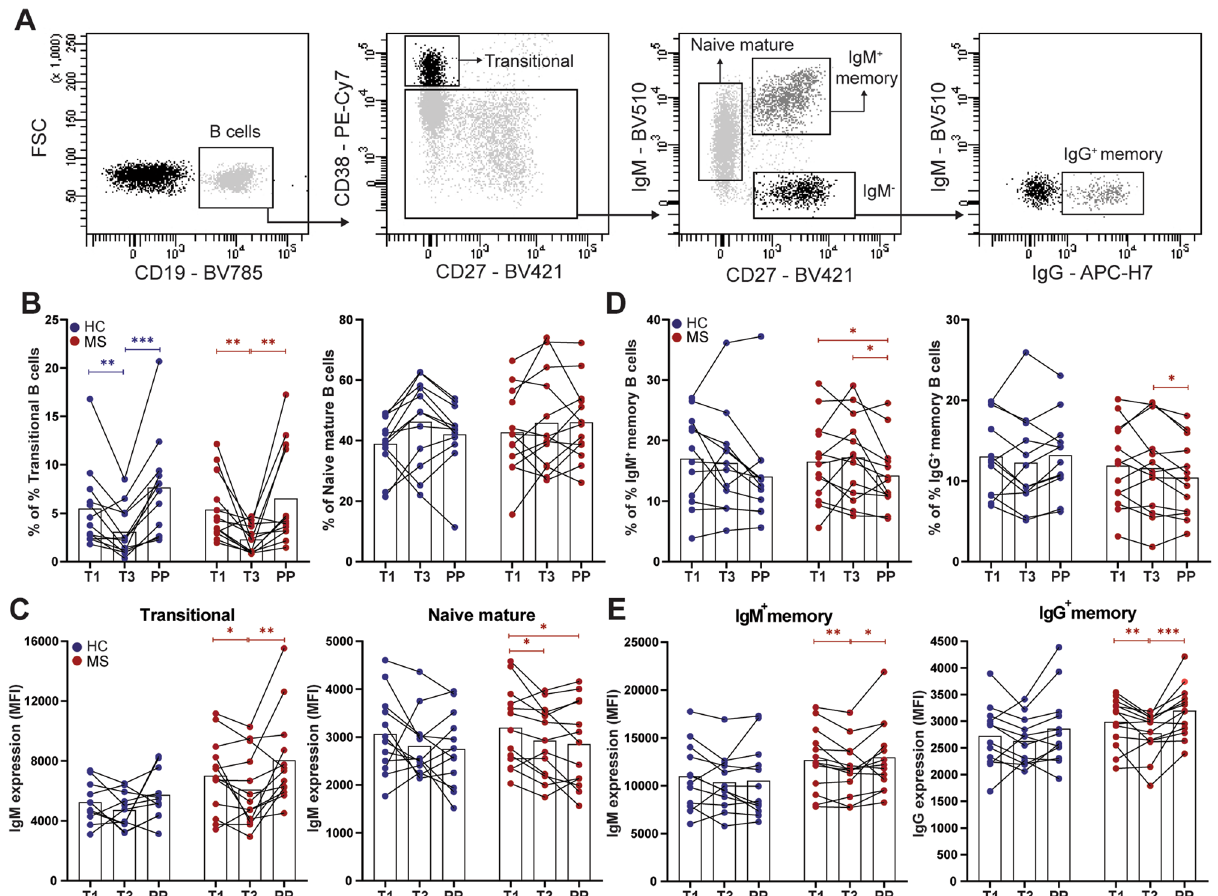
Figure 1. Frequencies of circulating naive and memory B-cell subsets during and early after pregnancy in MS patients and healthy controls. ( A ) Representative gating of viable CD19 + B-cell subsets: transitional (CD38 high CD27 - ), naive mature (CD38 -/dim CD27 - IgM + ), IgM memory (IgM + CD27 + ) and IgG memory (IgG + CD27 + ) B cells. The percentages of transitional and naive mature B cells ( B ) as well as IgM and IgD expression (MFI) on these subsets ( C ) were compared between paired first trimester (T1), third trimester (T3) and postpartum (PP) blood samples of 13 MS patients who did not experience a postpartum relapse (red) and 12 HC (blue). Similar analyses were performed for IgM + and IgG + memory B cells ( D , E ). Wilcoxon signed-rank test was performed to compared the different gestational periods. * p < 0.05, ** p < 0.01, *** p <